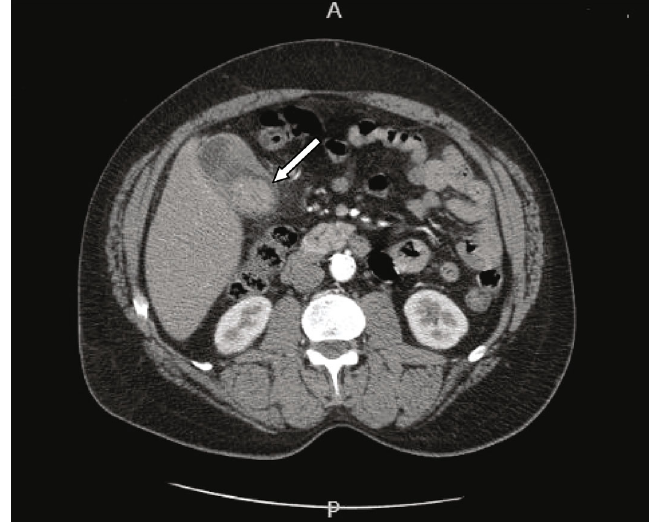
Figure 1: A noncontrast CT scan of the patient ’ s abdomen revealing thickening of the gallbladder wall with a possible polyp (white